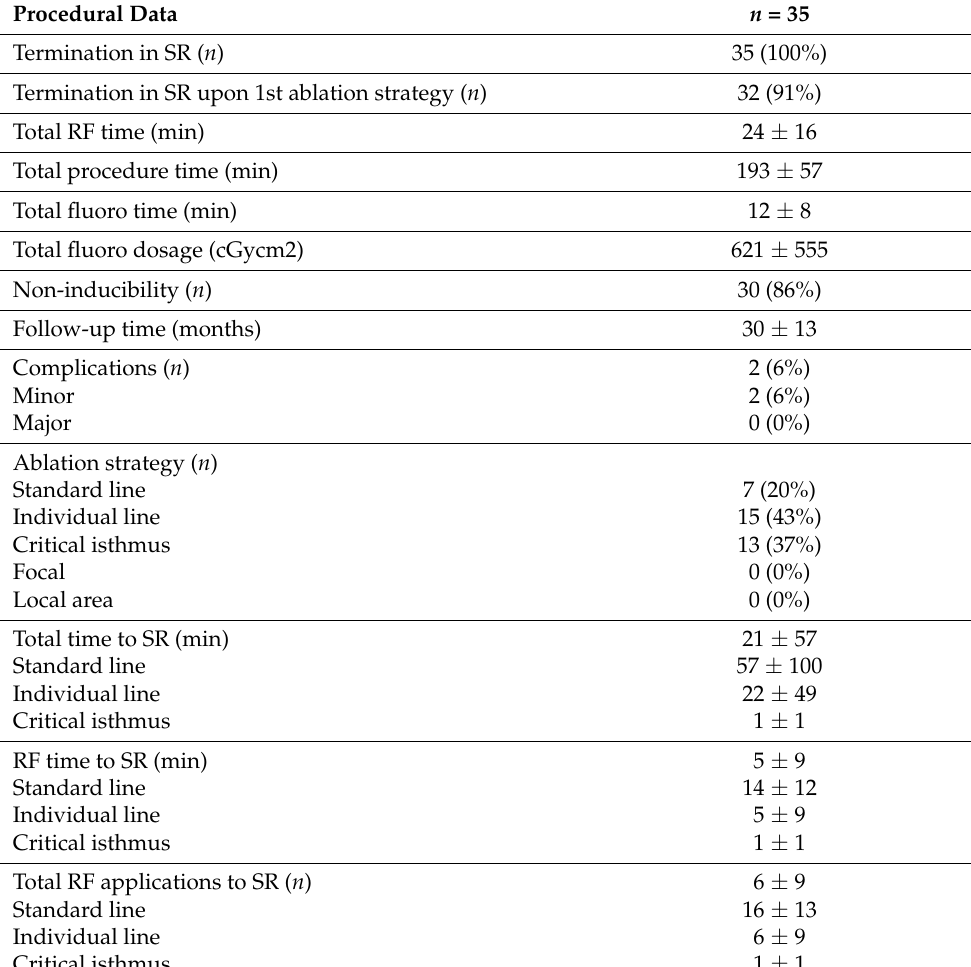
Table 2. Procedural